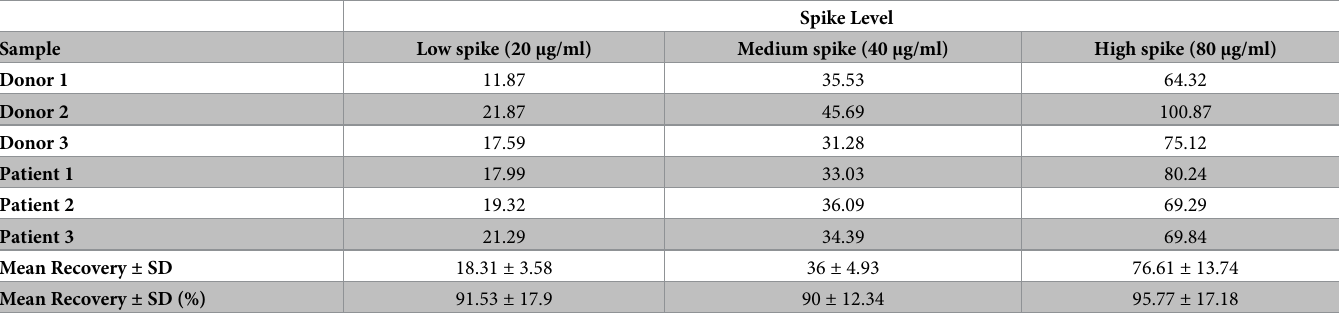
Table 2. Spike and recovery analysis.